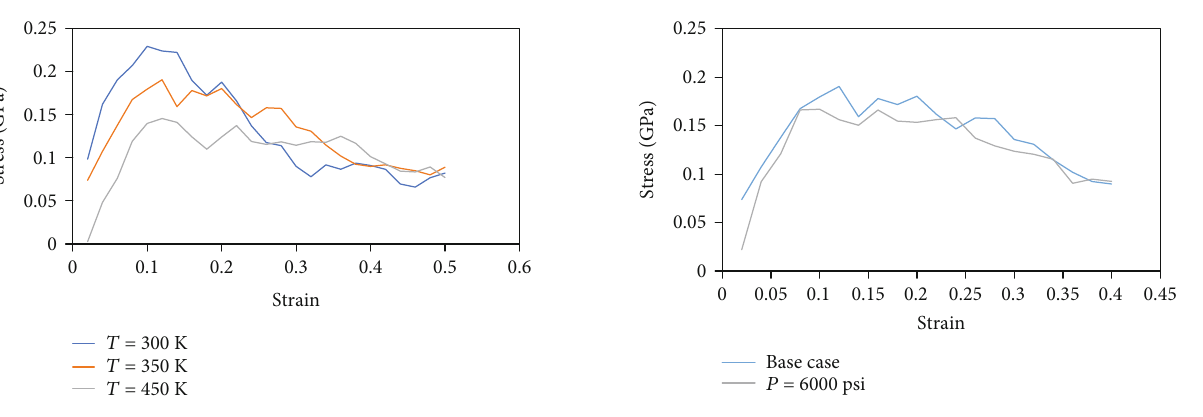
Figure 13: Tensile mechanical deformation of 6.45% porosity kerogen structure at 300 K, 350K, and 450K.